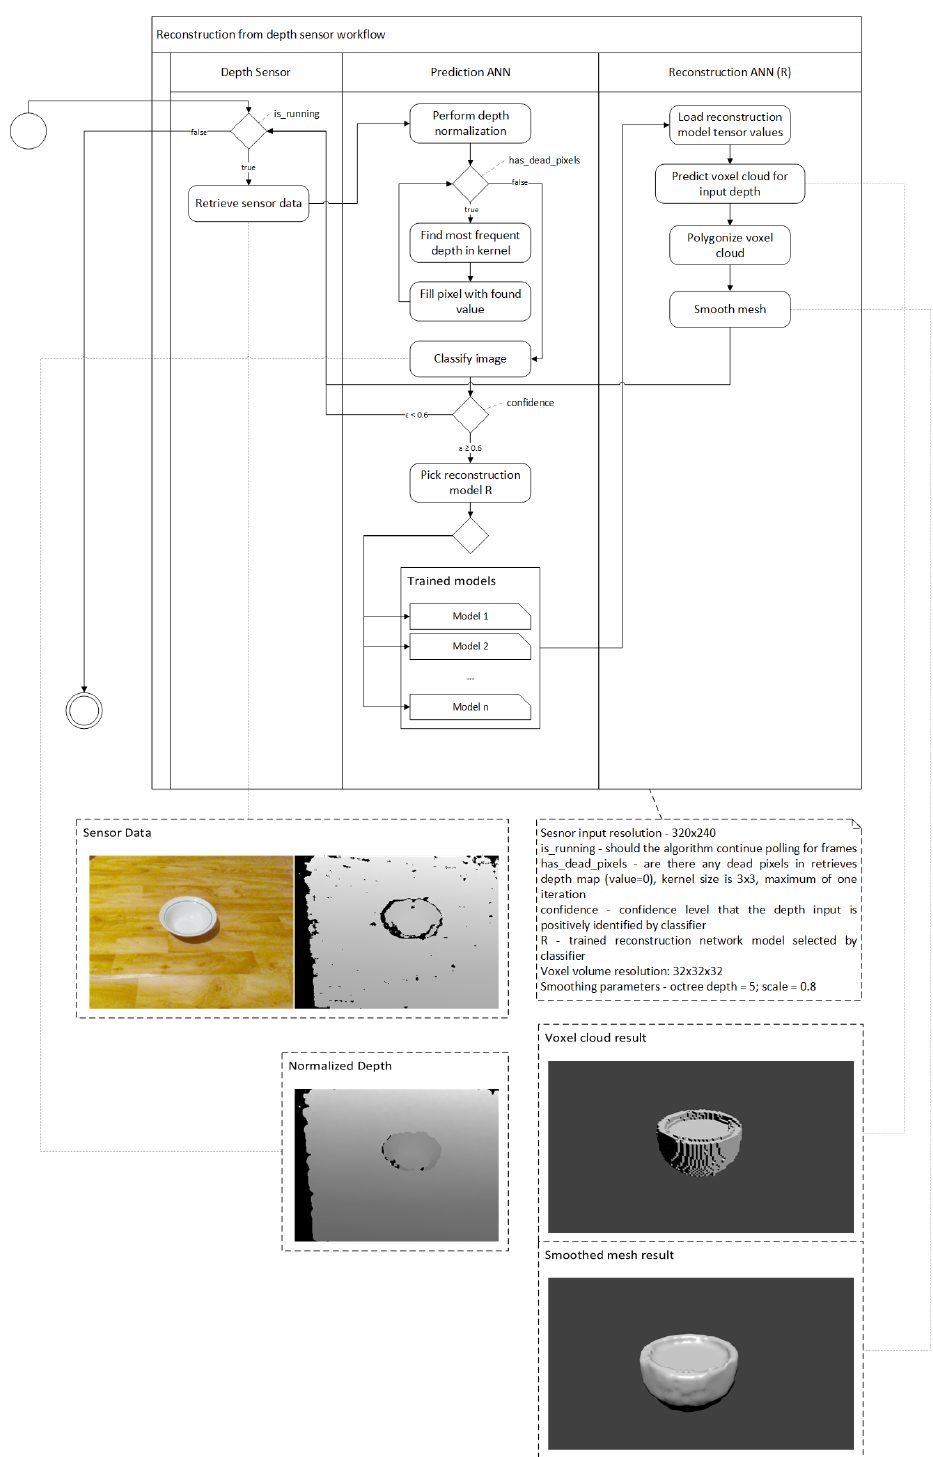
Figure 3. Depth sensor data is captured and sent to classifier ANN. If classifier network recognizes the object, the sensor data is sent to reconstruction ANN, otherwise the frame is dropped. Reconstruction ANN generates the voxel cloud. Voxel cloud is turned into polygonal mesh, and mesh smoothing is